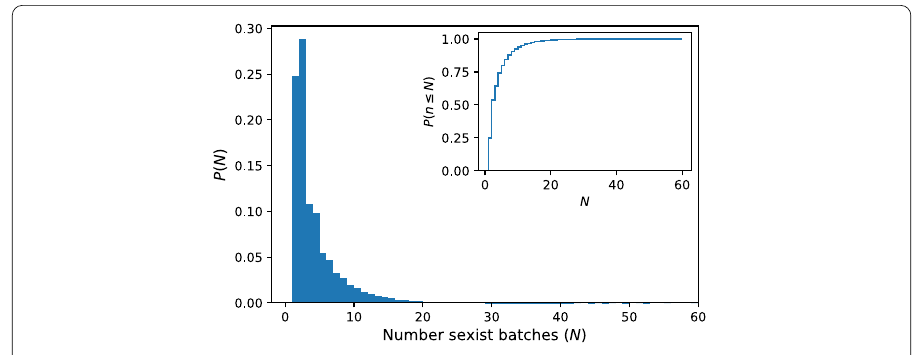
Figure 7 Distribution of the number N of batches per song classified as containing sexist content (ignoring songs with N = 0) with classification threshold at 0.725. The maximum number of sexist batches in a song is 60. The cumulative distribution is shown in the inset